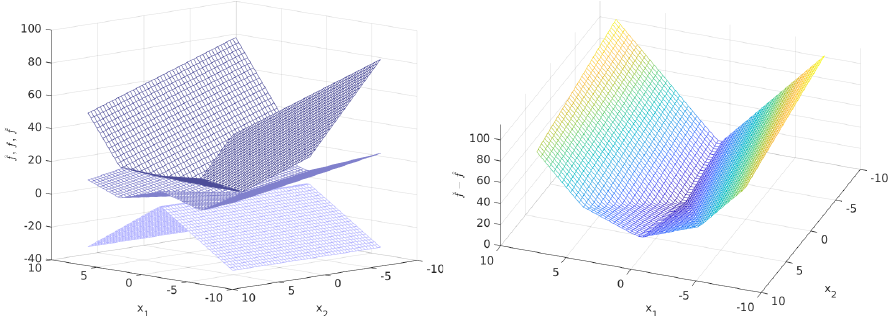
Figure 2. Nesterov–Rosenbrock test function polyhedral inclusion for n “